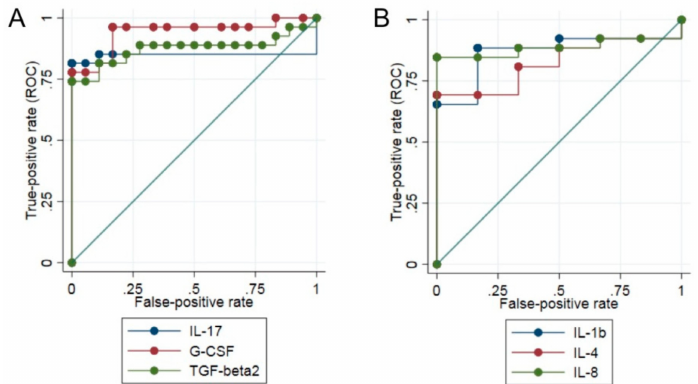
Figure 2. ROC analysis of the serum levels of IL-17, G-CSF and TGF-b2 for the comparison between the Musc-LMNA patients and controls ( A ) and of IL-1b, IL-4 and IL-8 between Musc-LMNA and LMNA-mutated groups ( B ). The true positive rate (sensitivity (SE)) on the y-axis is represented as a function of the false positive rate (100%—specificity% (SP)) on the x-axis. Higher y values correspond to a higher SE, and lower x values correspond to a higher